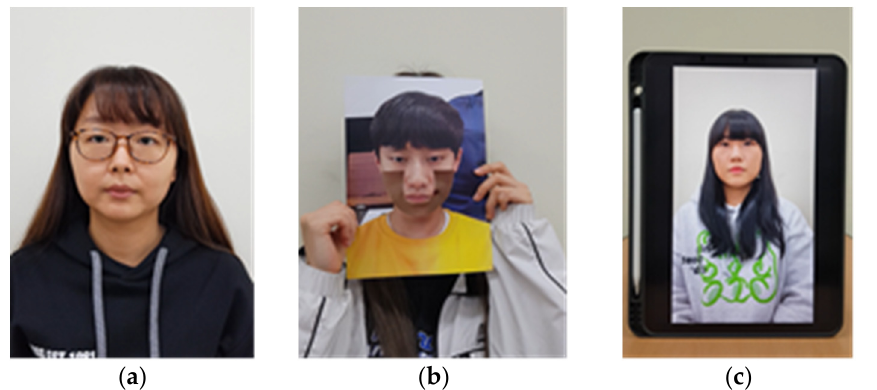
Figure 3. Data used for model training: ( a ) real face data; ( b ) cut off photo attack example; ( c ) replay attack example.